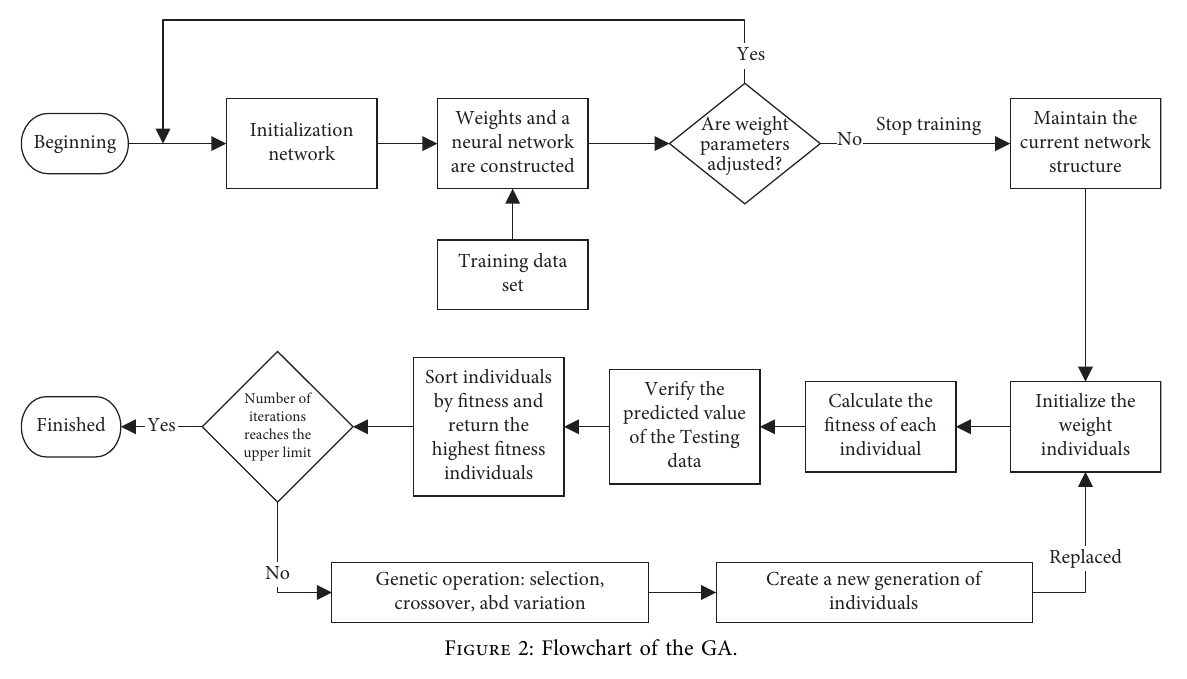
Figure 2: Flowchart of the GA.